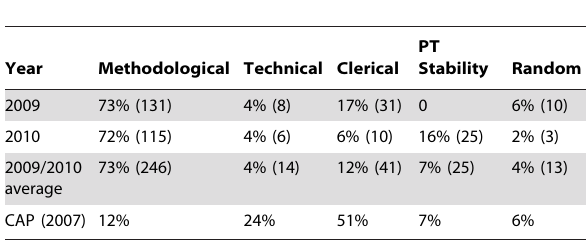
Table 3. PT error rates in 2009–2010 for all